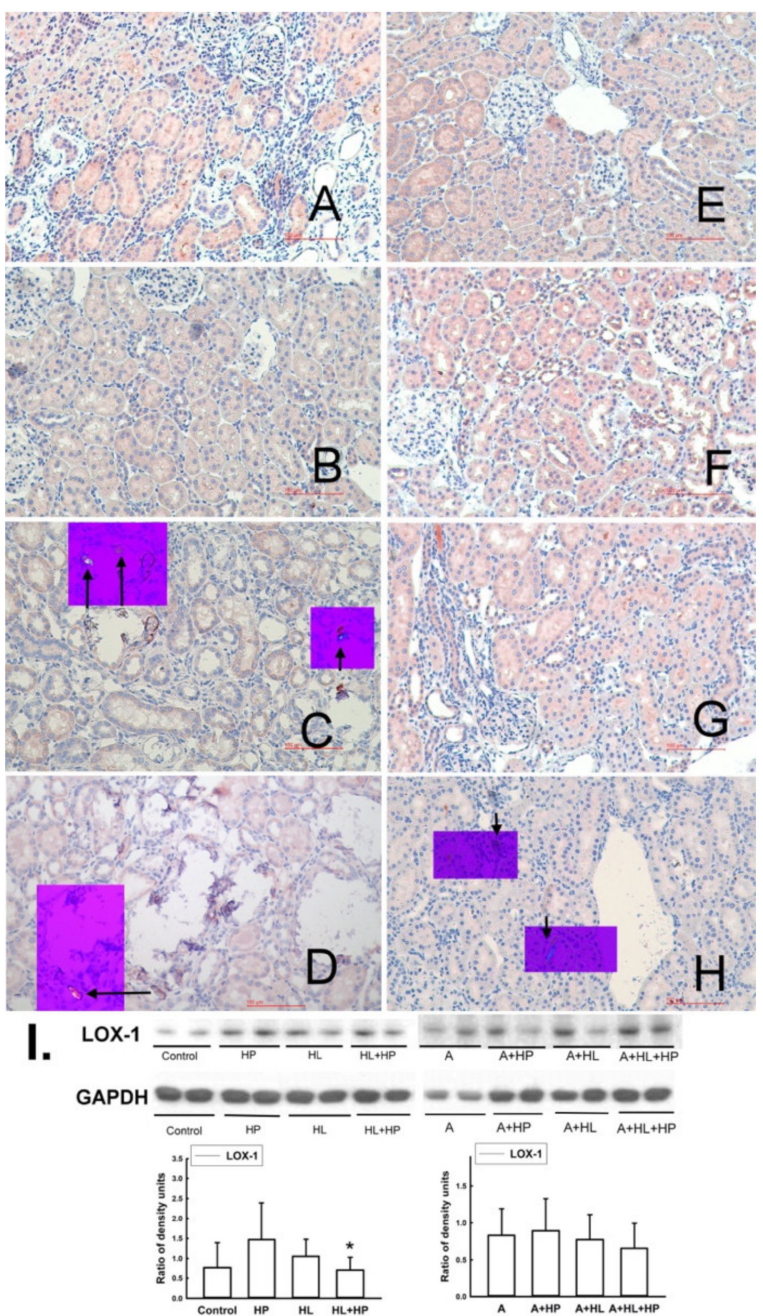
Figure 5. Representative micrographs of renal sections stained for LOX-1 (oxidized LDL receptor), Reduced from × 200. The small purple box shows the same renal section which was examined by polarized microphotography (Reduced from × 200) to observe CaOx or CaP deposition (indi- cated by black arrows) in the kidney. Left panel: A – D : Non-A (Atorvastatin) experimental groups: ( A ) Control group. ( B ) Hyperlipidemia (HL). ( C ) Rats treated with 5% hydroxyproline (HP). ( D ) HL rats treated with 5% HP: LOX-1 level decreased significantly compared to the levels in the control group ( p = 0.034) and the HP group ( p = 0.026). Right panel: E – H : A-treated experimental groups: ( E ) A group. ( F ) A + HP group. ( G ) A + HL group. ( H ) A + HL + HP group. All images above